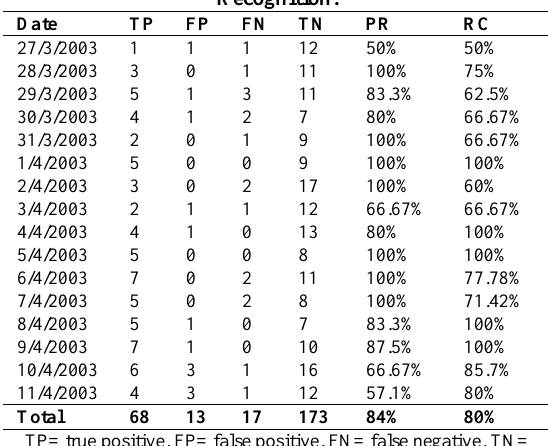
Table 7. Results of Proposed Method for Activity Recognition.